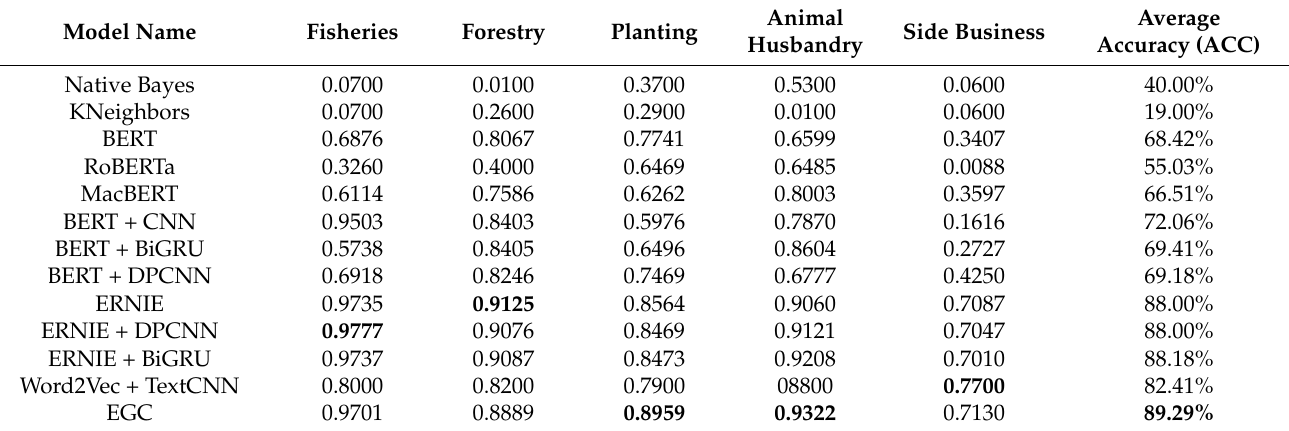
Table 5. Summary of experimental results for 13 models, with the best experimental results repre- sented in